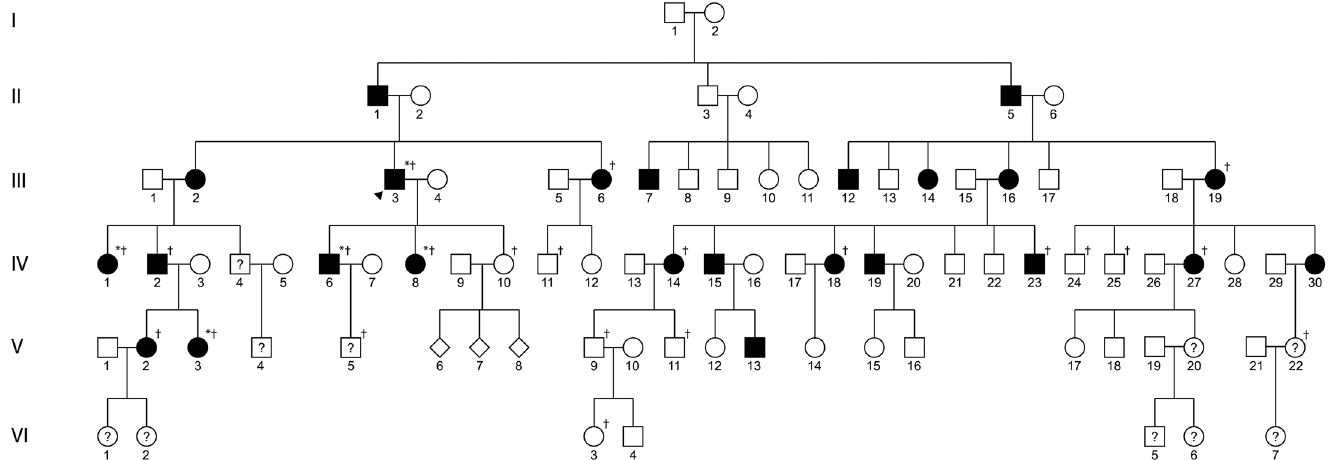
Fig 1. Pedigree of a family with chromosome 10q23-q24 linked dystrophy. Females are represented by circles, males by squares, and individuals of unknown gender by diamonds. Affected individuals are shown with filled symbols and unaffected individuals are shown with open symbols. Individuals of unknown affected status are shown with a question mark. The arrow head indicates the proband. An asterisk ( * ) indicates individuals that underwent WES. A dagger ( † ) indicates individuals that underwent Sanger sequencing for identified candidate variants in COL17A1 and DNMBP .